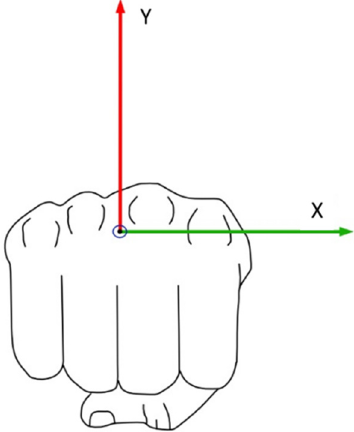
Figure 3 . Frontal view of the right punching fist with highlighted metacarpal heads. Figure 3. Frontal view of the right punching fist with highlighted metacarpal